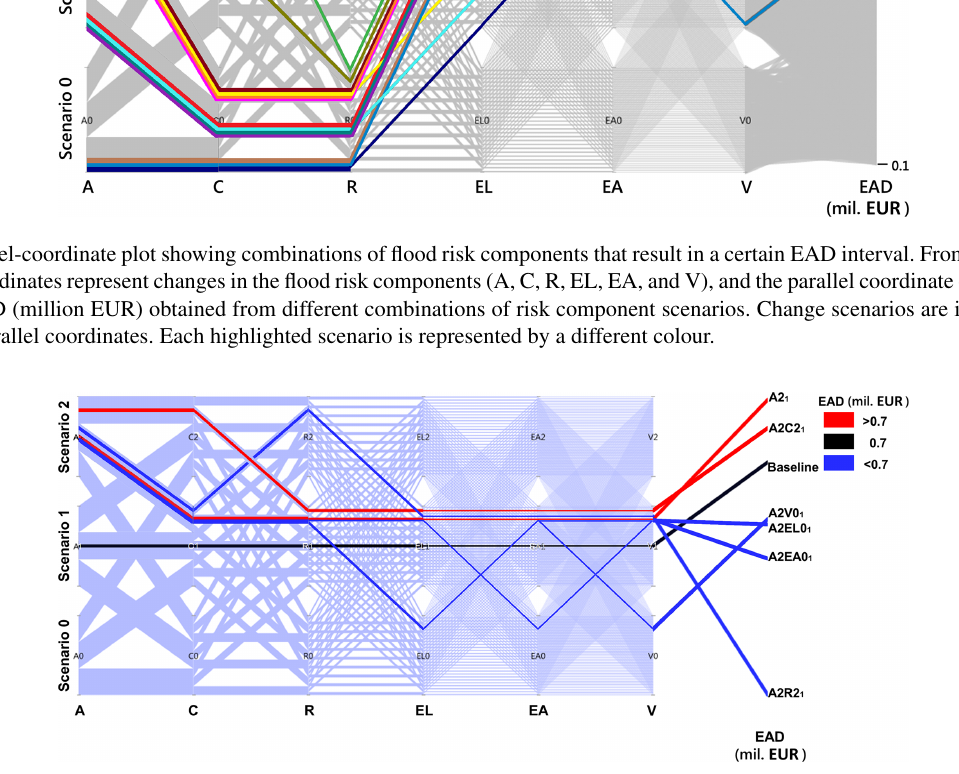
Figure 10. Parallel-coordinate plot representing the baseline scenario (Scenario 1) for all components and six combinations of flood risk components with a warmer climate scenario (A2): A2 1 , A2C2 1 , A2R2 1 , A2EL0 1 , A2EA0 1 , and A2V0 1 , where subscript “1” shows that all other unwritten components are in their baseline